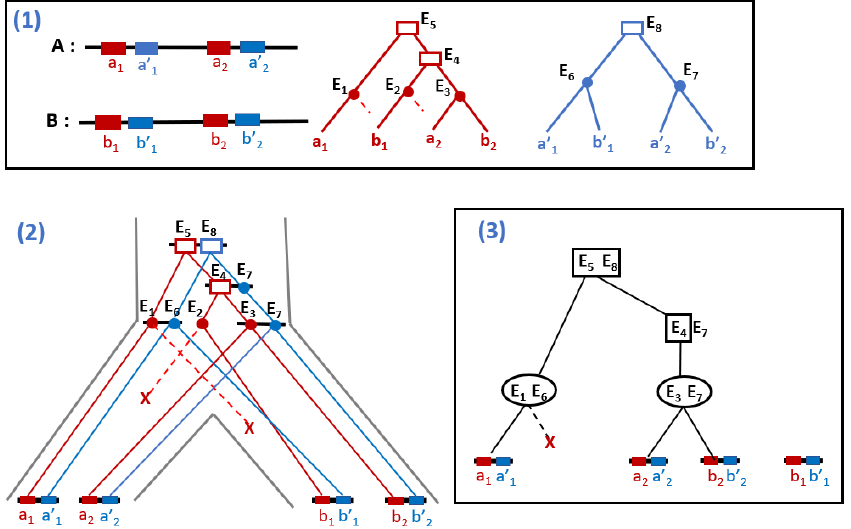
Figure 4. ( 1 ) Input of D E C O : a set of adjacencies between two gene families, the red and blue ones, in two genomes A and B; reconciled gene trees for the red and blue families, where rectangles are gene duplications, plain circles are speciation and dotted lines are grafted edges for gene losses; ( 2 ) An evolutionary history embedded in the species tree S = ( A , B ) explaining the evolution of the adjacencies through gene duplication, speciation and gene loss; ( 3 ) The output of D E C O in the form of a forest of two trees, representing the evolutionary history of ( 2 ). The simultaneous duplication of the two adjacent genes corresponding to E 5 and E 8 is an adjacency duplication. The dotted line represents a gene loss. For a unitary cost of adjacency gain and breakage and a 0 cost for other events, the left tree in ( 3 ) has cost 0, while the right one has a cost of 1, for the gain of adjacency b 1 b (cid:48)